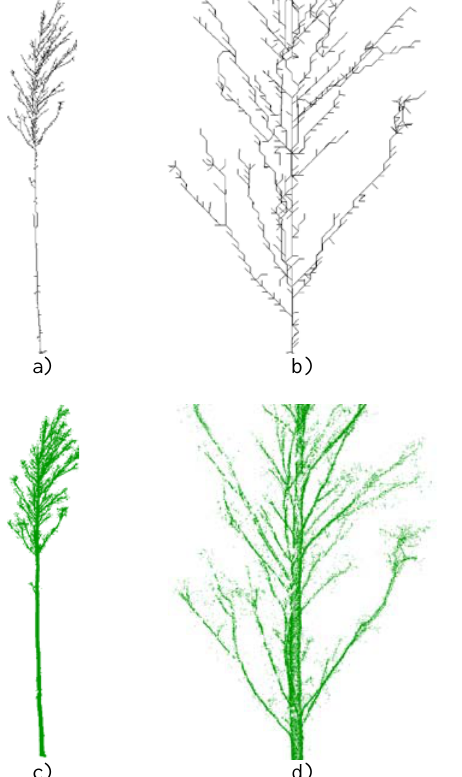
Figure 6. a) and b) Tree topology